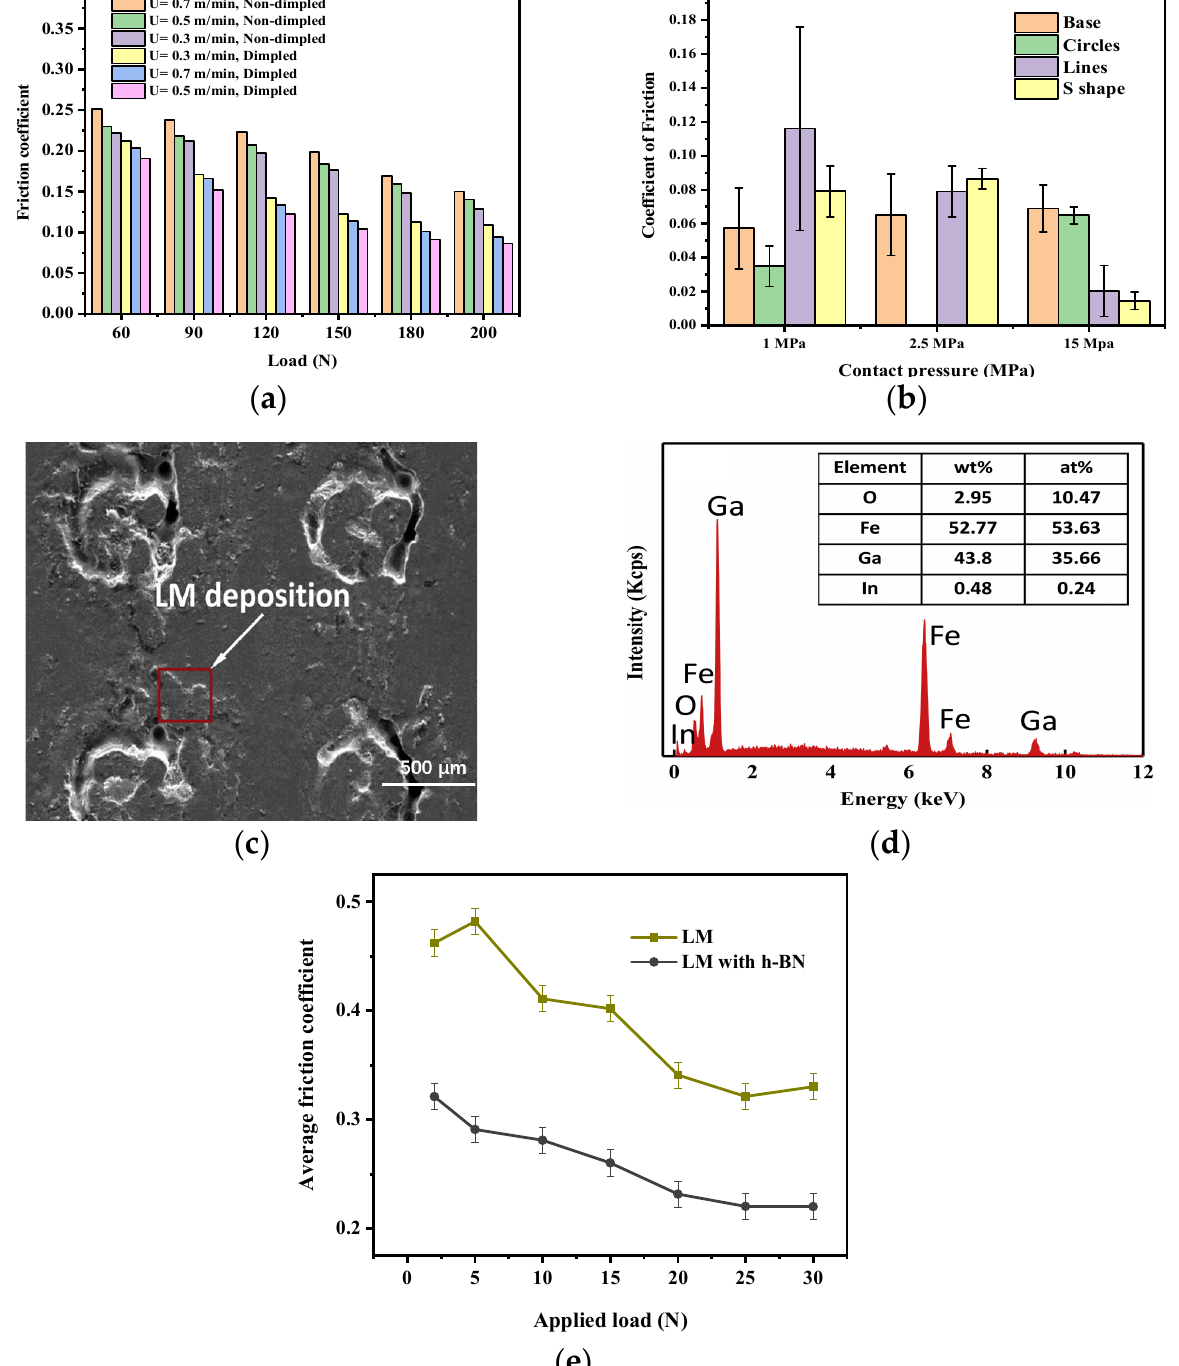
Figure 9. ( a ) the coefficient of friction with applied loads at distinct sliding velocities, reprinted with permission from [116], copyright from Elsevier 2010; ( b ) the COF with different texture geometries at 1 and 15 MPa, reprinted with permission from [67]. Copyright from Elsevier 2021; ( c ) SEM wear scar and LM deposition; ( d ) EDS evaluation of LM lubrication under extreme conditions of 10 N, 4 Hz, and 15% area density, reprinted with permission from [81], copyright from Elsevier 2019; ( e ) average friction with LM and LM with 8 wt% h-BN nanosheets under various applied loads, reprinted with permission from [119]. Copyright from Elsevier 2021.